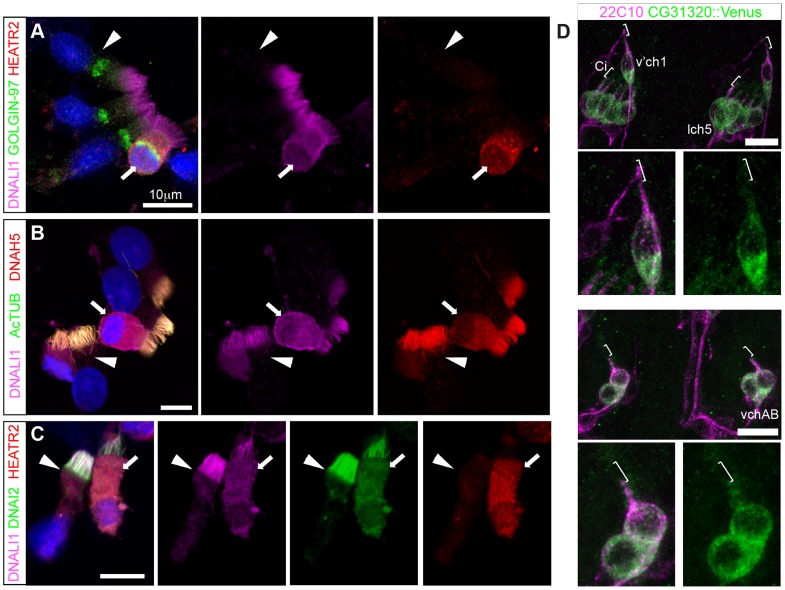
Cytoplasmic HEATR2 is expressed during early ciliogenesis.(A–C) Immunostaining of control human nasal brush epithelia reveals endogenous HEATR2 (red: Novus (A), Proteintech (C)) is highly enriched in the cytoplasm of developing MMC when components of outer dynein arms (B: DNAH5, red; C: DNAI2: green) as well as inner dynein arms (A–C: DNALI1, purple) are predominantly cytoplasmic. Arrowheads highlight fully mature MMCs where these components are exclusively axonemal and with relatively lower levels of HEATR2. Arrows highlight immature MMCs for comparison. Nuclei are stained with DAPI (blue). (Scale bar: A–C, 10 µm) (D) Double immunofluorescence of 22C10 (magenta: Futsch, cytoplasmic/membrane marker, but not cilium, of all sensory neurons) and CG31320::mVenus (green) indicates there is cytoplasmic but no ciliary localization of CG31320 in stage 16 Ch neurons (Ci: cilia, marked with square bracket). As this construct uses the upstream regulatory region of CG31320 containing the X and Fox motifs to drive reporter expression, it further supports regulation occurs via these sites. (See Figure S7).